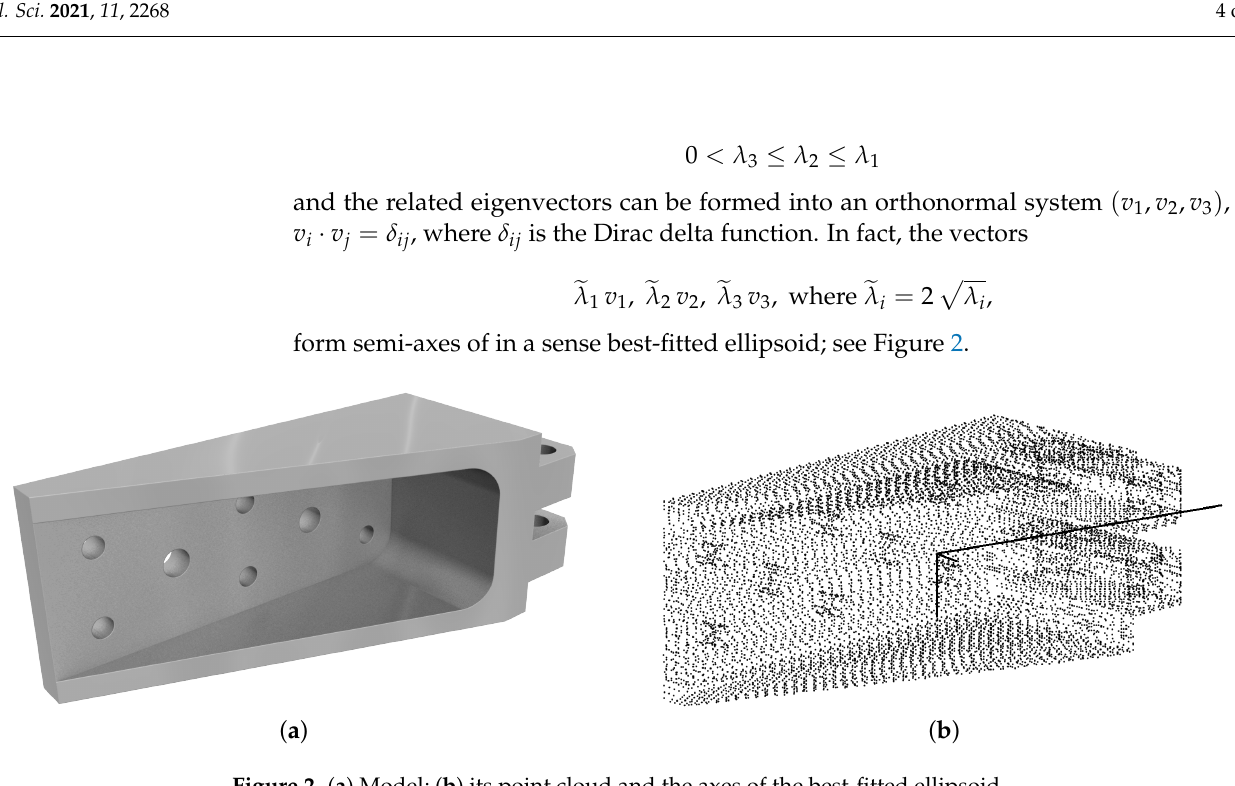
Figure 2. ( a ) Model; ( b ) its point cloud and the axes of the best-fitted